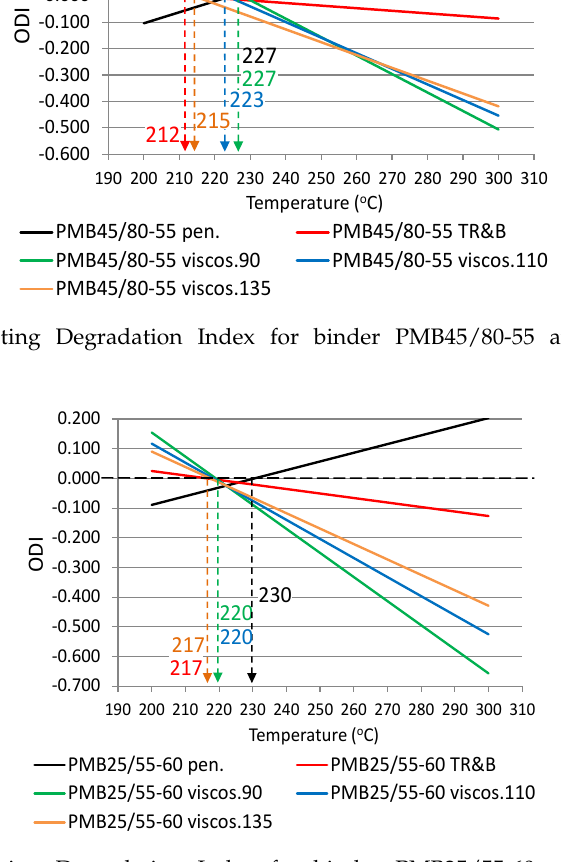
Figure 8. Overheating Degradation Index for binder PMB25/55-60 and determination of temperature T (ODI) .